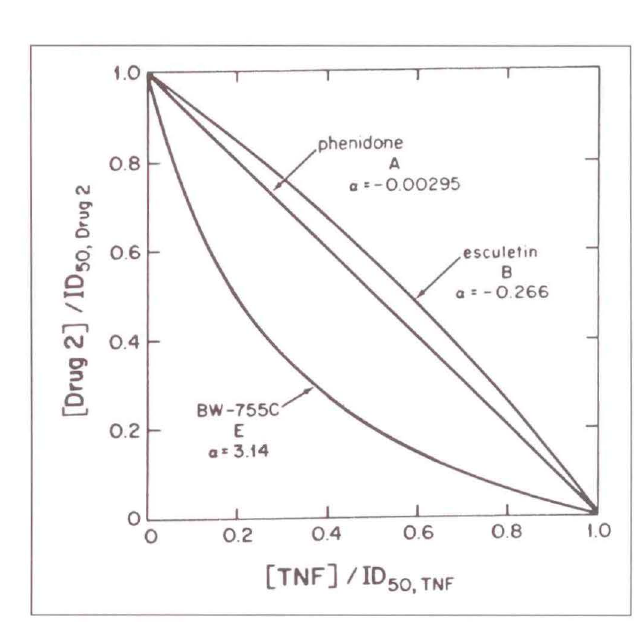
Figure 5) Estimated two-dimensional isobol contours at the median effective dose, IDso. for the three concentration-effect surfaces shown in Figure 4. The curves were estimated as described in Figure 4 and in the text. Thi!; two-dimensional representation accents the degree of bowing of the swjaces away .from the straight-line prediction of additivity.